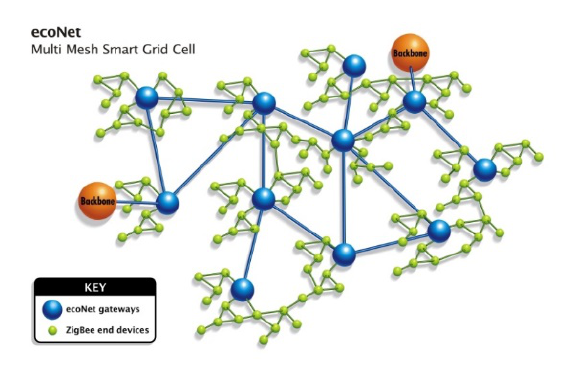
Figure 2: Example of Smart Grid Network [http://www.nexgrid.net/